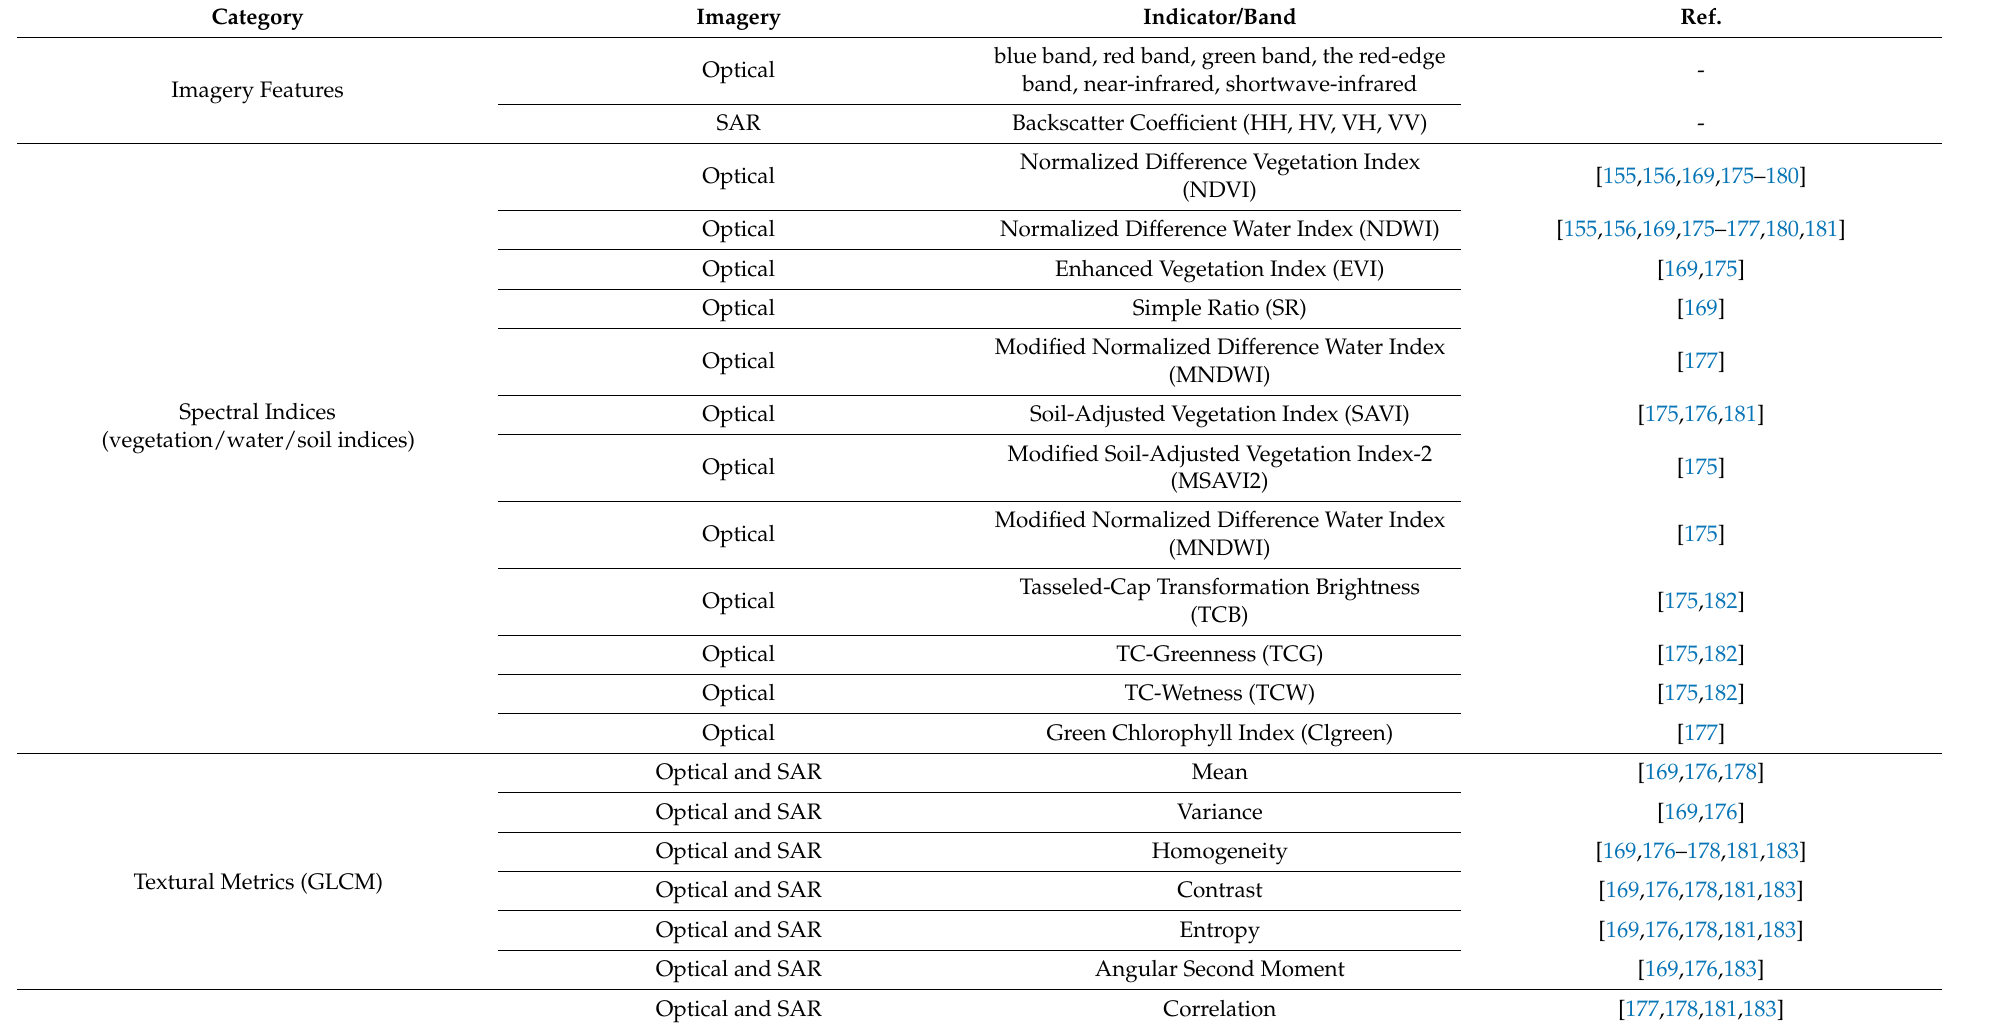
Table 8. Common features extracted from Optical and SAR imagery in wetland